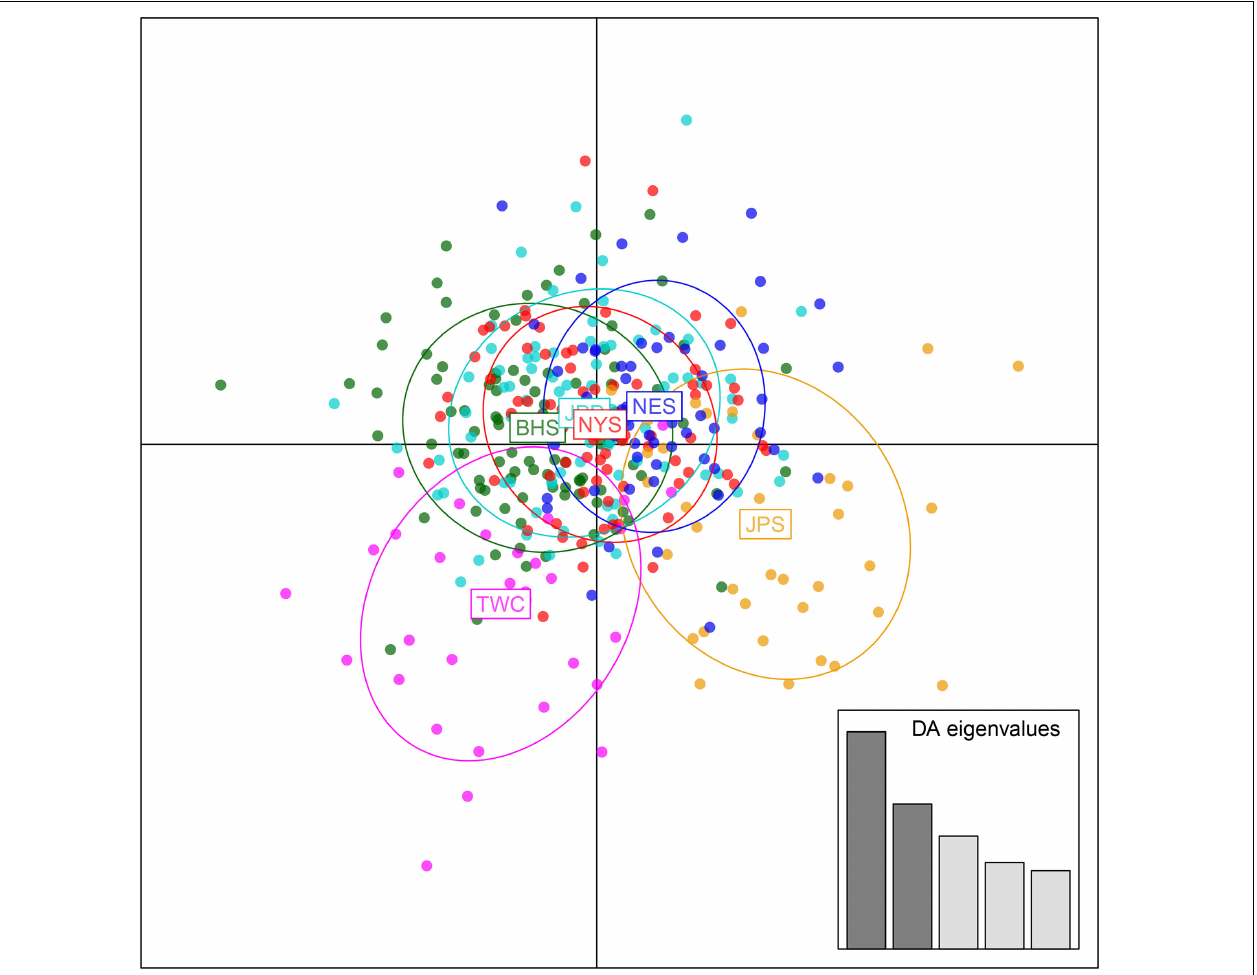
FIGURE 2 | Discriminant analysis of principal components (DAPC) plots for 12, 627 SNPs in six regional populations of E. japonicus . Ellipse centers of each cloud of points represent each sampling regions.